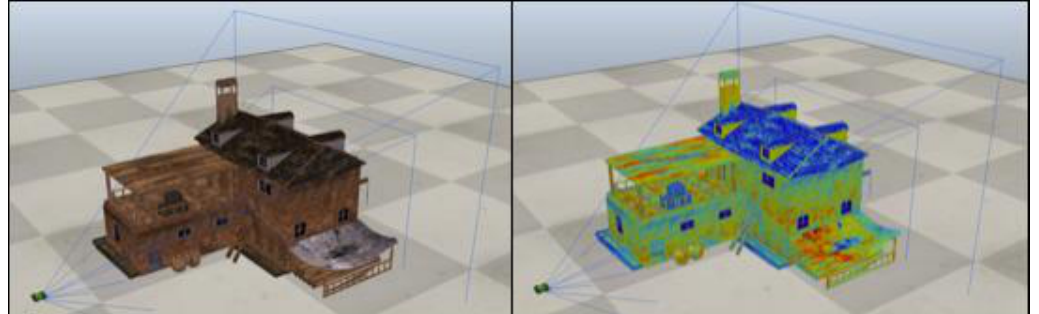
Figure 6. The virtual environment with the texture for the visible (left) and for the thermal bands (right).